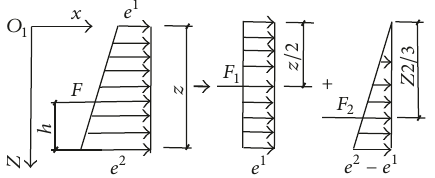
Figure 4: Sketch map of antisliding inclined pile soil stress analysis.